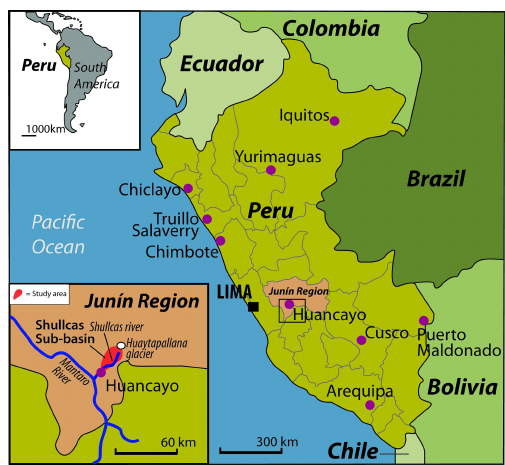
Figure 1. Location of the Rainfalls Peru research site. Source: Mi- lan and Ho (2014; their Fig.